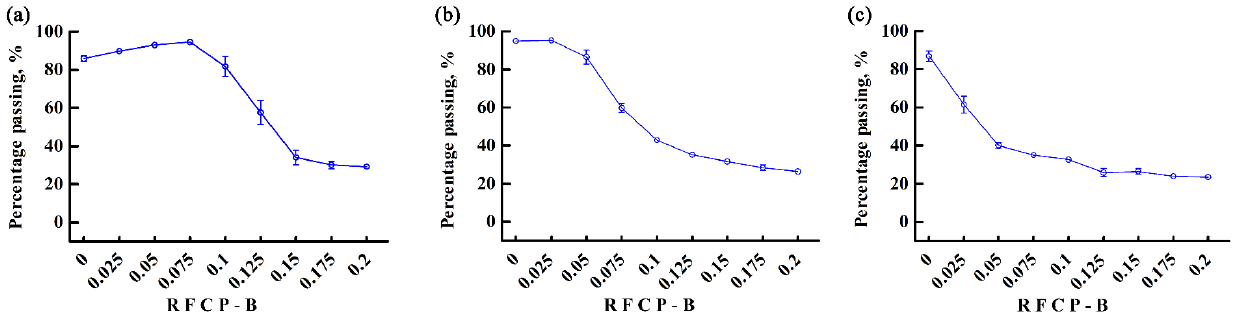
Figure 12. The relationship between percentage passing and RFCP-B for ( a ) SN42, ( b ) JD17, and ( c ) ZD39.